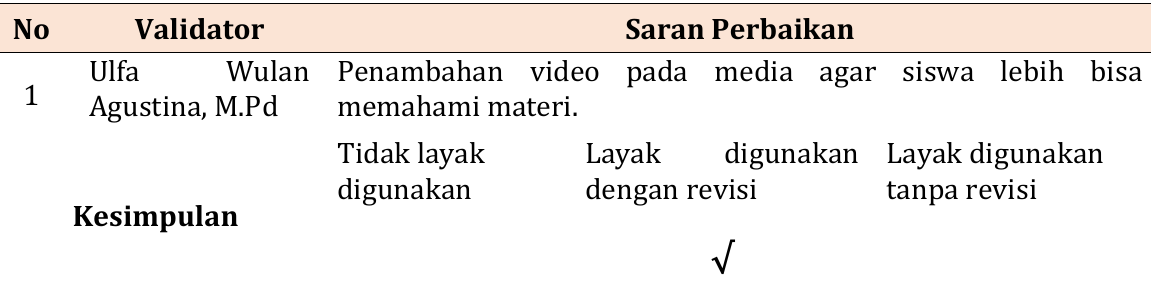
Table 5. Improvement Suggestion by Media